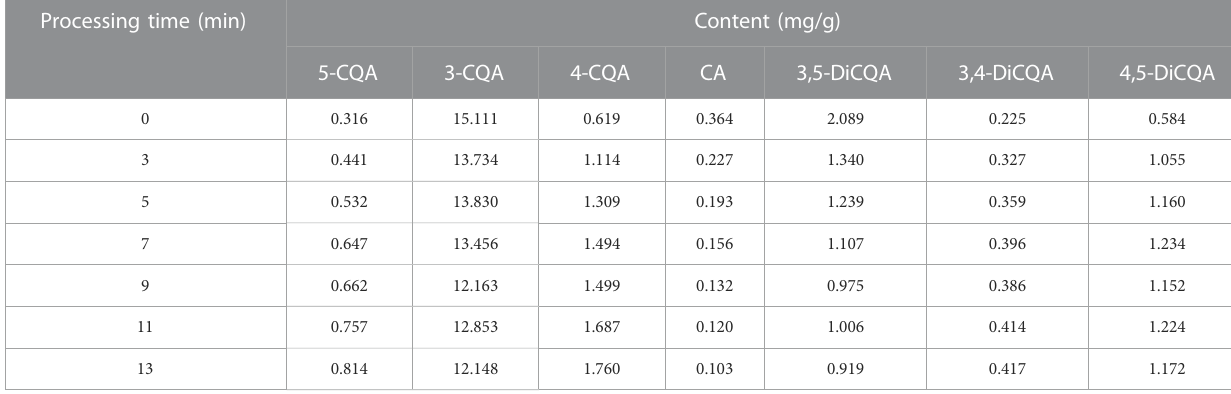
TABLE 3 Content changes of the main compounds in PS during the stir-frying process (120 ° C). Processing time